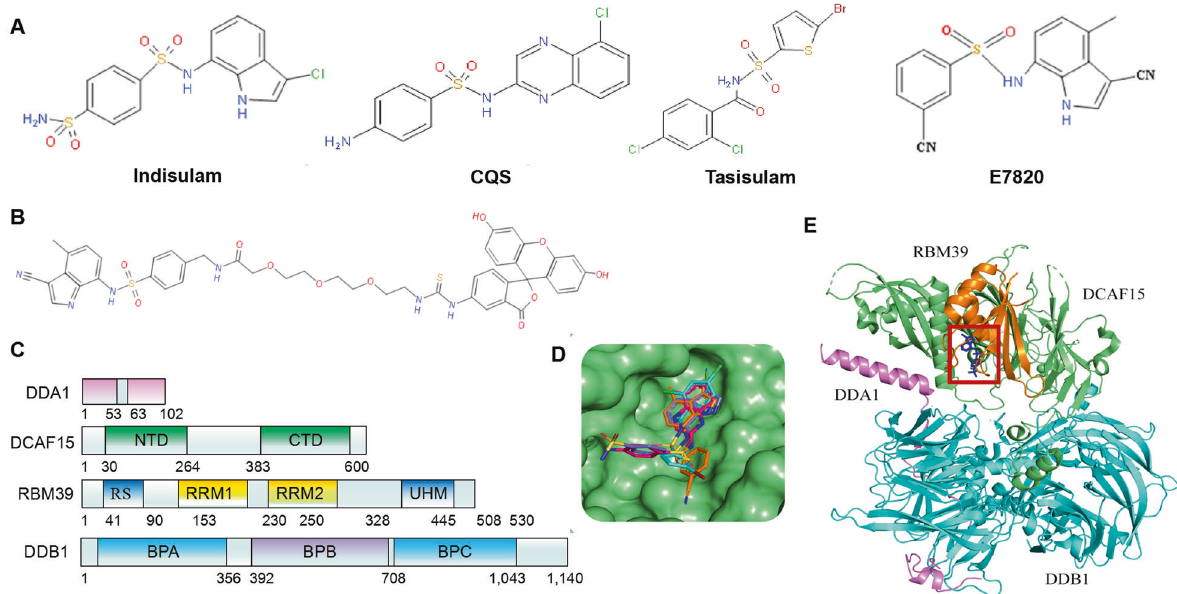
Fig. 3 Structure of the complex of DDA1 – DDB1 – DCAF15 – RBM39 with SPLAMs. A Chemical structures of indisulam, CQS, tasisulam and E7820. B Substitution reaction in the RBM39-indisulam interaction. C Domain representation of the proteins present in the complex. D The surface of DCAF15 is represented as green, and CQS, E7820, indisulam and tasisulam are represented as rods in red, orange, blue and cyan respectively. E Overall quaternary structure of human DCAF15 – DDB1 – DDA1 – RBM39 (RRM2) in complex with aryl sulfonamides. DCAF15 is shown in green, DDB1 in blue, DDA1 in purple and RBM39 (RRM2) in orange. The aryl sulfonamide-binding site between DCAF15 and RBM39 is outlined in red.